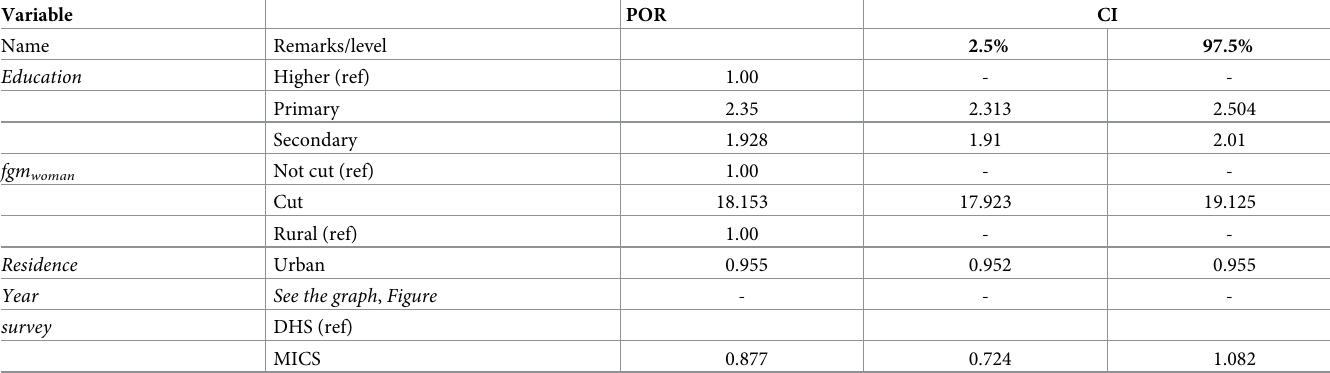
Table 5. Posterior odds ratio estimates from the Bayesian geo-additive regression model (adjusted) fitted to the pooled 2003 to 2016 dataset.